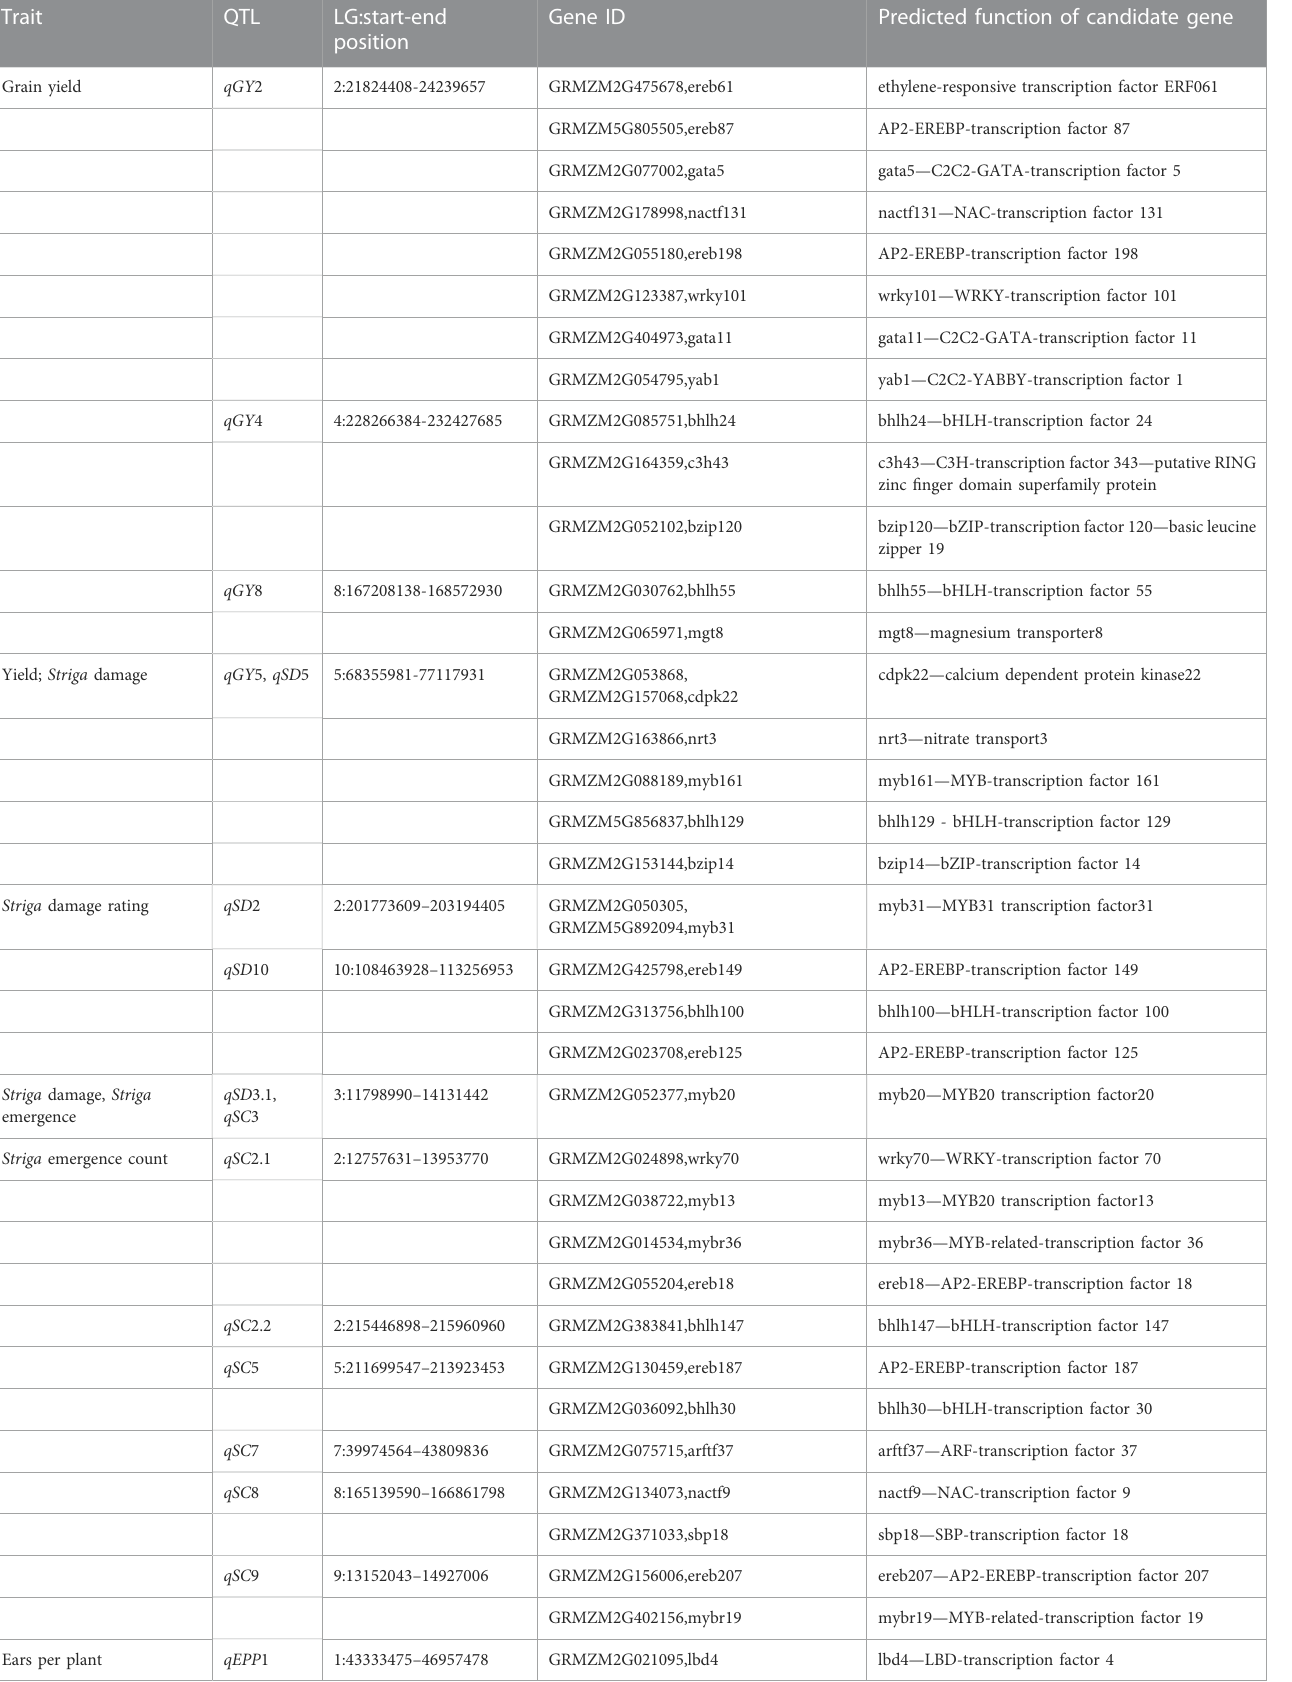
TABLE 6 Key candidate genes associated with QTLs detected from the F 2:3 mapping population evaluated under arti fi cial Striga